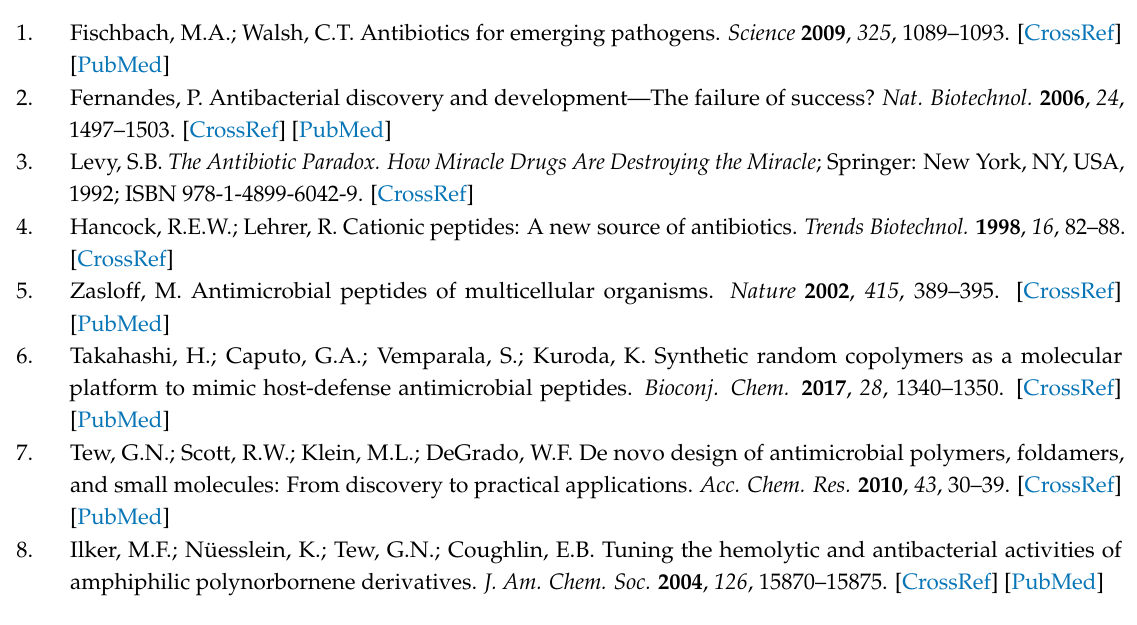
Table S1: Characterization, bactericidal activity and hydrophobic dye uptake behaviors for poly(IBVE- co -AEVE)s with different MP IBVE s, Figure S1: Fluorescence intensity of DPH (50 nM) versus polymer concentrations for poly(IBVE- co -AEVE)s with different MP IBVE